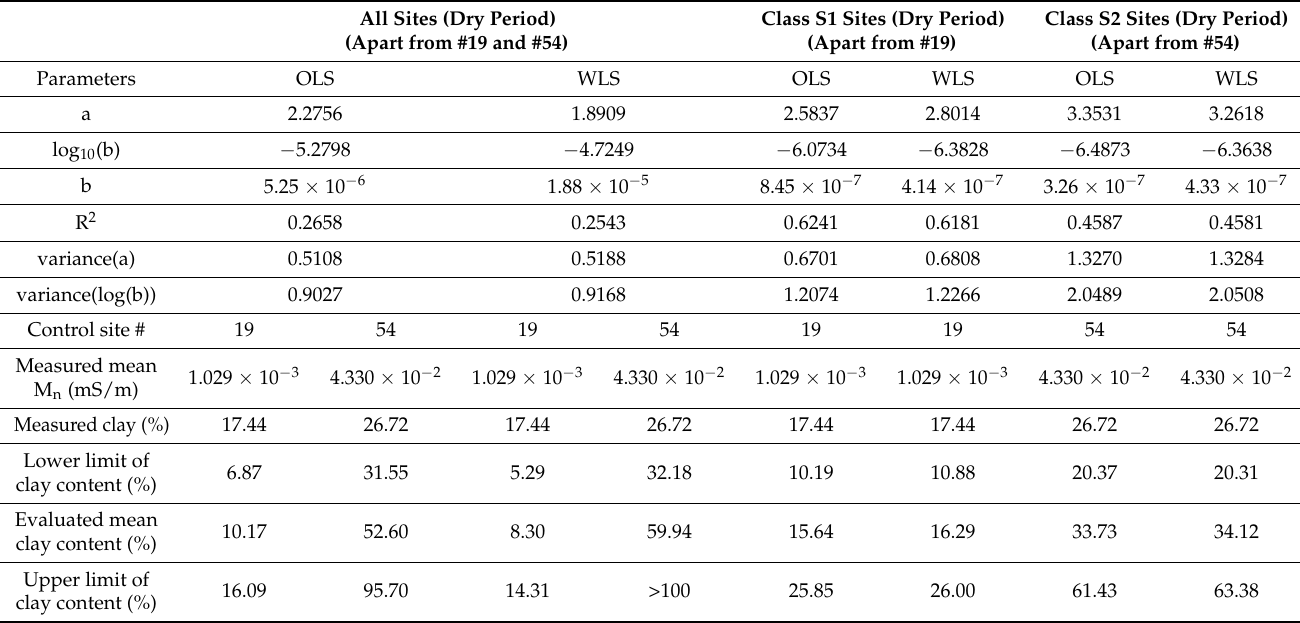
Table 2. Regression parameters and evaluation of the clay content at control sites #19 and #54, using the data from all sites and from sites distributed in classes S1 and S2 deduced from the geological classification of the surveyed